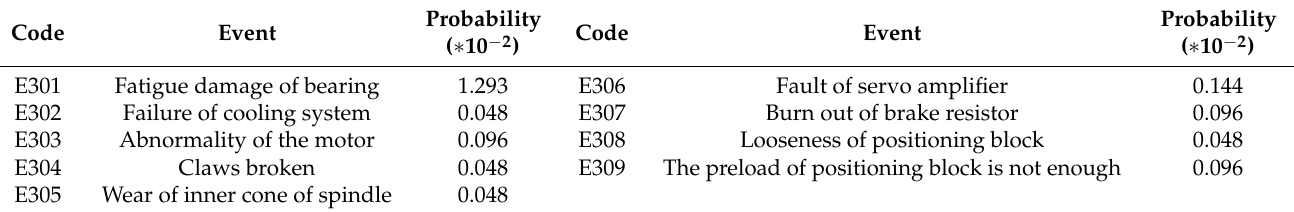
Table 3. Failure probability of each bottom